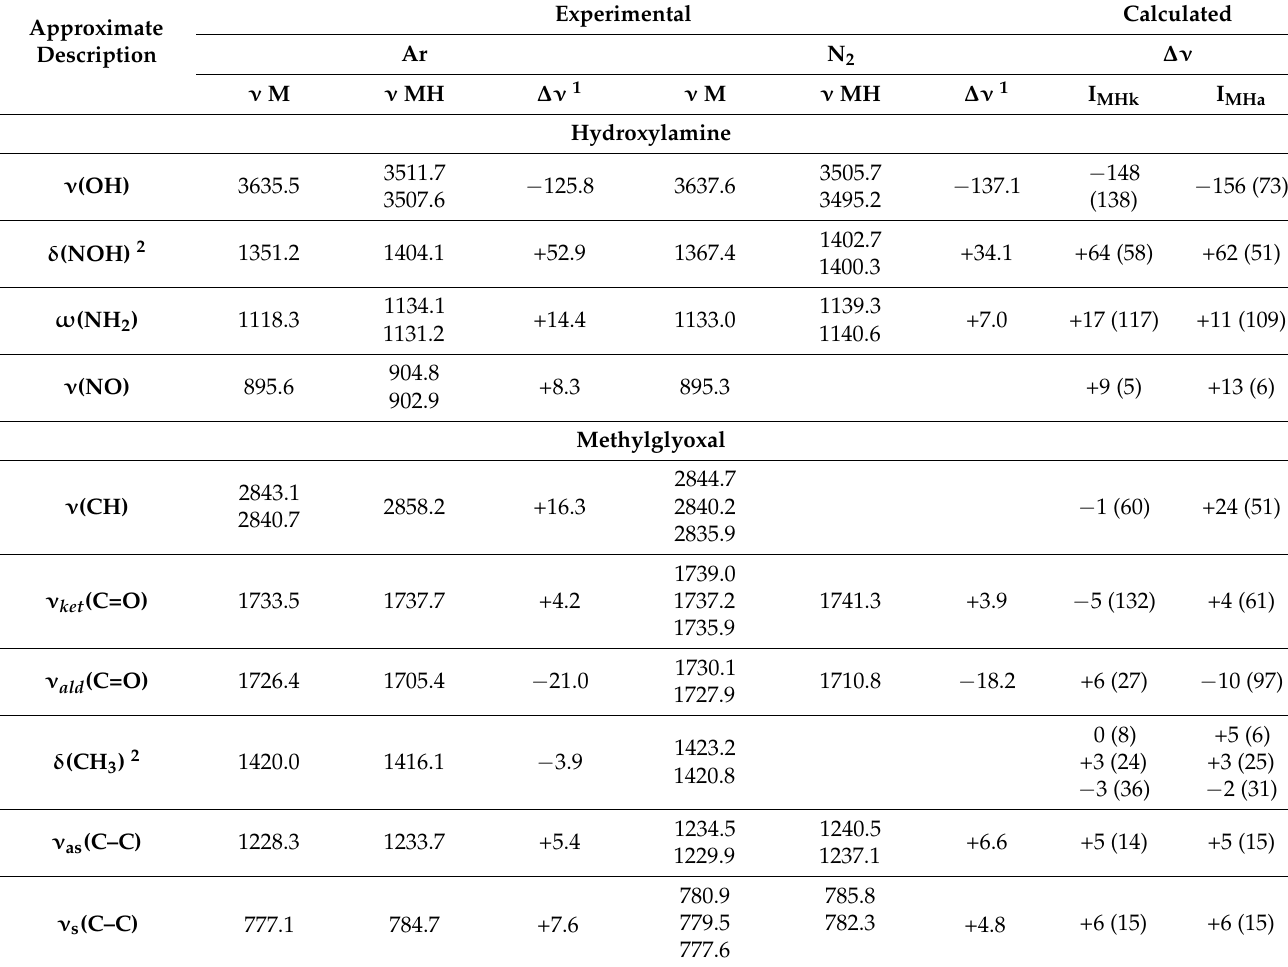
Table 3. The comparison of the observed wavenumbers (cm − 1 ) and wavenumber shifts ( ∆ ν = ν MH − ν M) for the CH 3 COCHO–NH 2 OH (MH) complexes present in the Ar and N 2 matrices with the corresponding calculated values for the complexes I MHk and I MHa . In parentheses, the calculated band intensities are given (km mol − 1